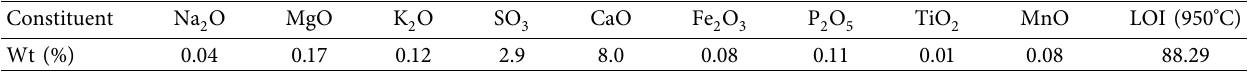
Table 2: Chemical composition of CL